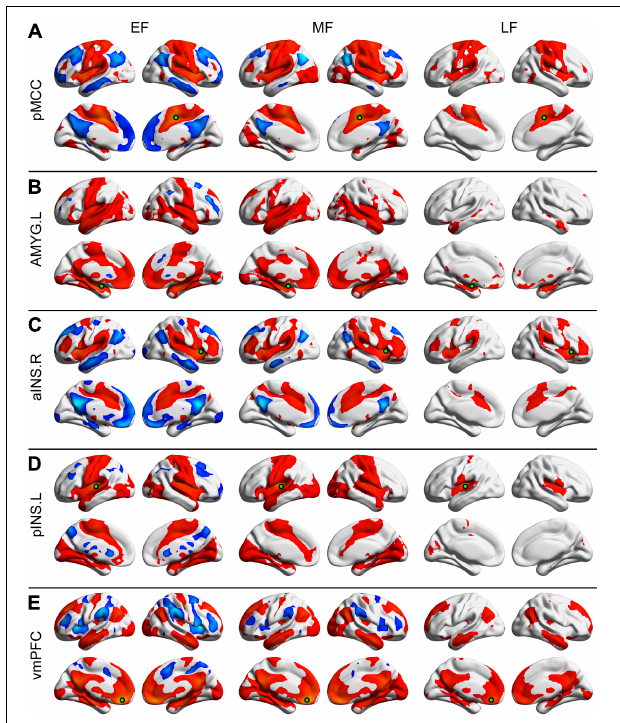
FIGURE 1 | Positive and negative functional connectivity maps seeded from the posterior midcingulate cortex (pMCC) (A) , the left amygdala (AMYG) (B) , the right anterior insula (aINS) (C) , the left posterior insula (pINS) (D) , and the ventromedial prefrontal cortex (vmPFC) (E) for the early- (EF, left column), middle- (MF, middle column), and late-adulthood females (LF, right column) (the seed was a 6 mm radius sphere shown in green; red and blue color indicated positive and negative connectivity maps, respectively, with a permutation test correction threshold of p < 0.05).